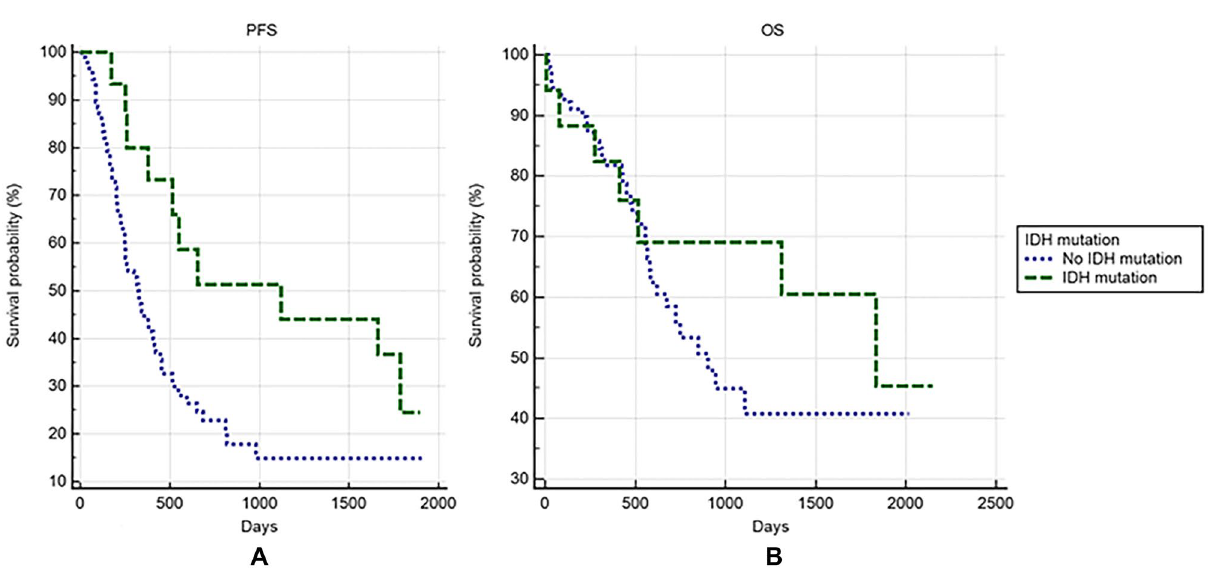
Figure 3. Oncological outcomes between patients with and without IDH1 Scalp block and IDH1 mutation are associated with improved PFS but not OS. Scalp block was associated with longer PFS (Fig. 2A, median PFS: 15.17 [8.87–37.37] vs. 10.77 [6.97–12.77] months in scalp block vs. non-scalp-block groups, respectively; p = 0.0018). However, scalp block was not associated with longer OS (Fig. 2B, median OS: 43.70 [22.50–61.13] vs. 31.47 [18.83–36.83] months in scalp block vs. non-scalp-block groups, respectively; p = 0.4929). Although the IDH1 mutation was associated with longer PFS (Fig. 3A, median PFS: 37.37 [8.63–59.53] vs. 10.90 [8.27–13.77] months in IDH1 mutation carrier vs. noncarrier groups, respec- tively; p = 0.0149), the IDH1 mutation was not associated with longer OS (Fig. 3B, p = 0.4021). Higher pathology grade and tumor location are additional risk factors associated with reduced OS.